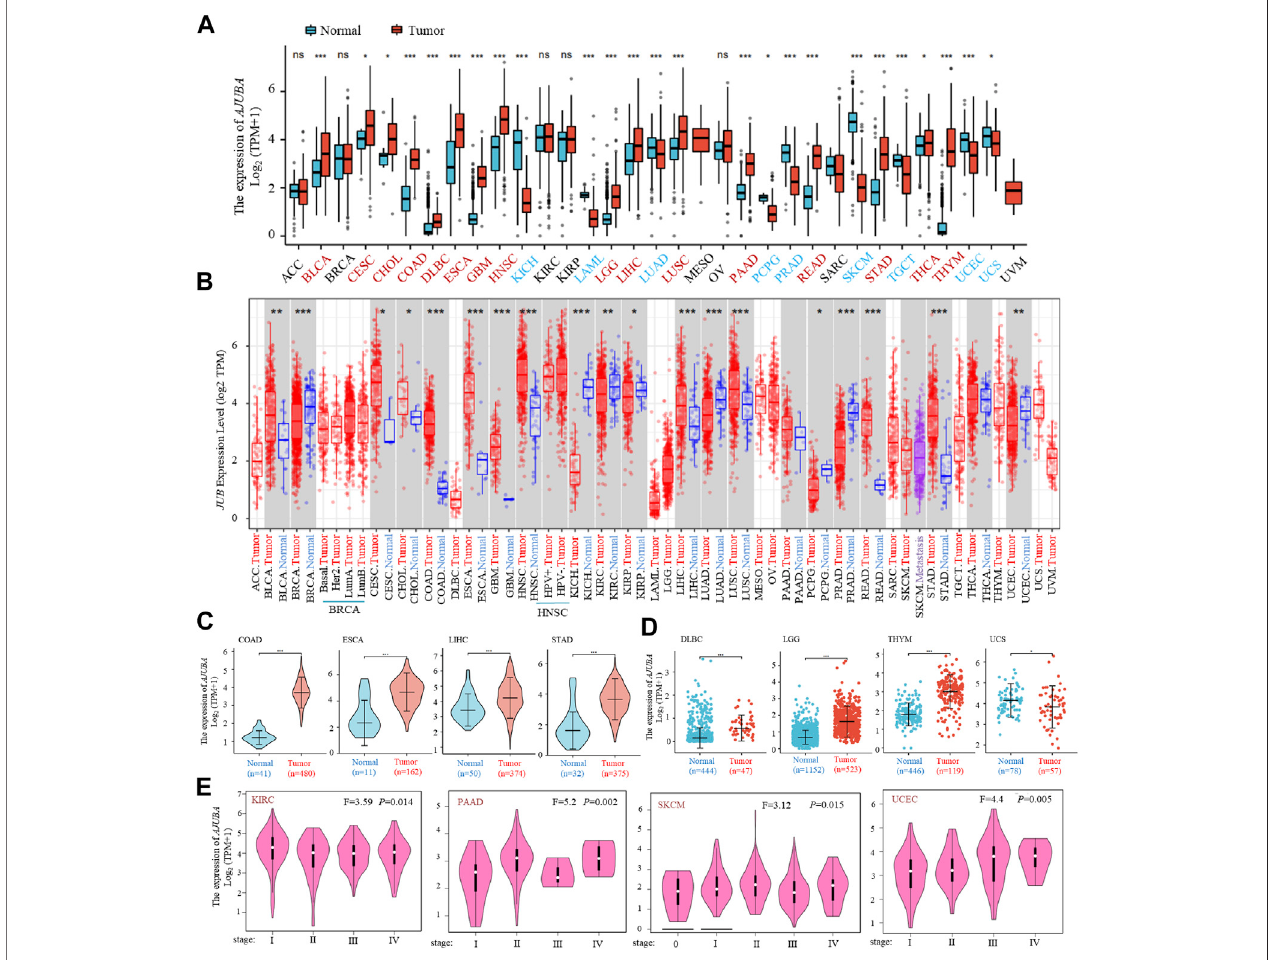
FIGURE1| AJUBAgeneexpressionindifferentcancersandpathologicalstages. (A) geneexpressionpro fi lesoftheAJUBAgeneinvariouscancerswasanalyzed via The Cancer Genome Atlas (TCGA) and Genotype-Tissue Expression (GTEx) databases. (B) the expression status of the AJUBA gene in various cancers or speci fi